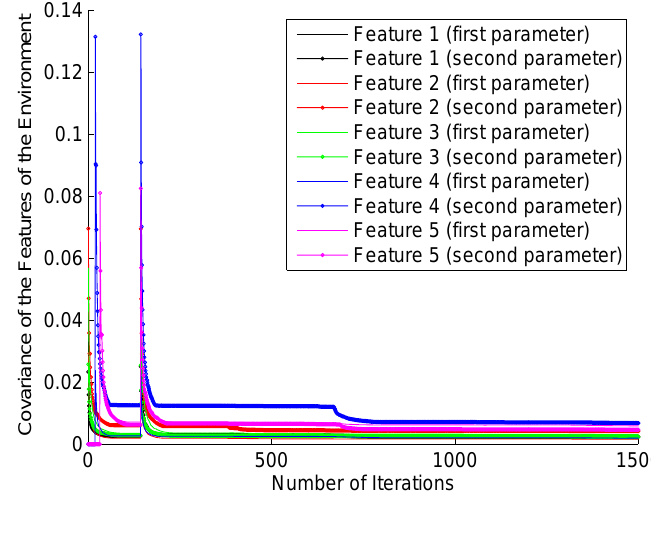
Figure 12. Covariance evolution of a set of five features—with two parameters—according to the estimation carried out by the full EKF-SLAM without feature